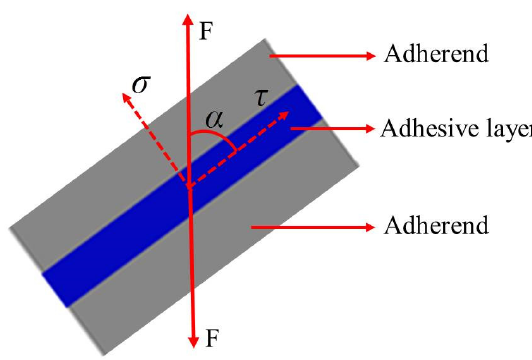
Figure 3. Stress vector in the adhesive layer of the adhesive joint. In this study, butt joints tested at different loading angles (0 ◦ , 45 ◦ , and 90 ◦ ) using a modified Arcan assembly were selected to represent three stress states (normal stress, nor- mal/shear combined stress, and shear stress, respectively). For convenience of description, they are denoted by BJ, 45 ◦ SJ, and TASJ, respectively. The 45 ◦ SJ ( α = 45 ◦ ) is subjected to a combination of shear stress and normal stress, and the ratio of the normal stress to the shear stress component of the joint is 1, while the α of TASJ and BJ is 0 ◦ and 90 ◦ , respectively. The ratio of normal stress σ to shear stress τ for TASJ, 45 ◦ SJ, and BJ is 0, 1, and + ∞ , respectively. Hence, BJ has the highest proportion of normal stress in the adhesive layer, followed in decreasing order by 45 ◦ SJ and TASJ.